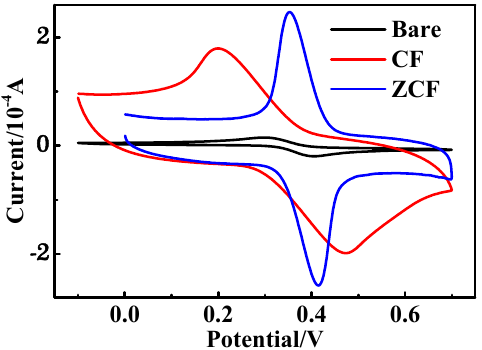
Figure 5. The cyclic voltammetry curves of bare GCE, ZCF/GCE, and CF/GCE in 0.1 M hydrochloric acid solution containing 1 mM HQ at a scan rate of 20 mV/s.